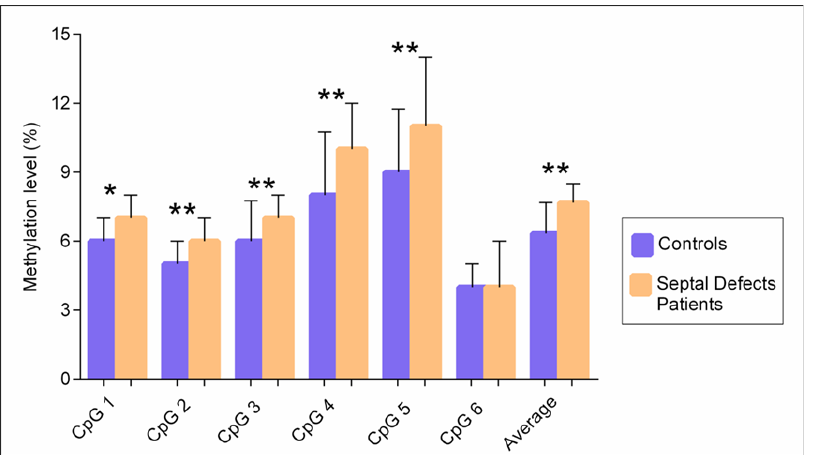
Figure 3 . Median methylation levels for 6 CpG sites in the TBX5 gene between patients with septal defects and the controls. * p < 0.05, ** p < 0.001; Mann–Whitney U test.